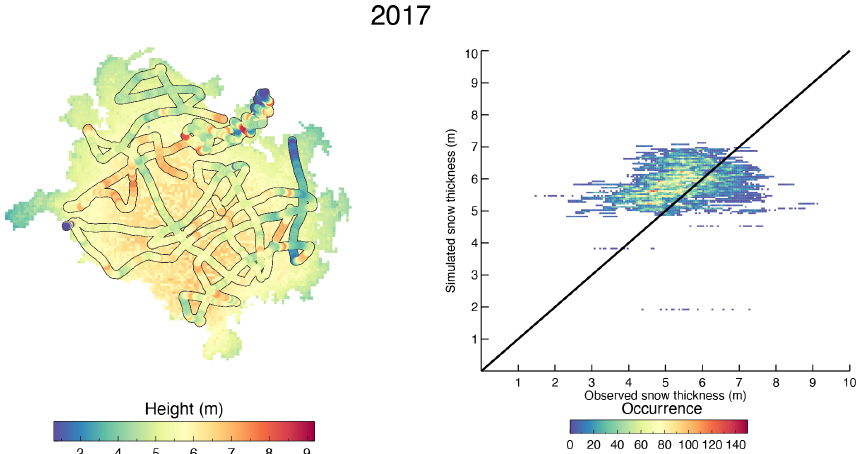
Figure 13. Simulated and GPR observed snow depth for 2017 but with no effect of sublimation from snow drift in the